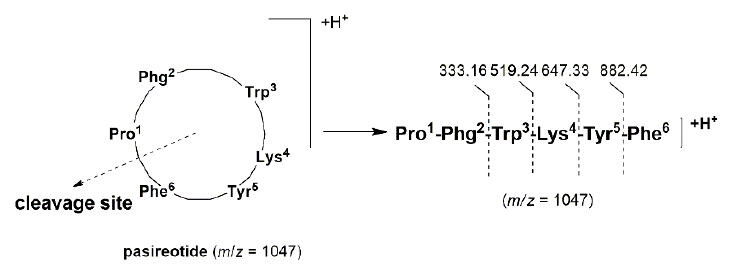
Scheme 6. Cleavage site of protonated pasireotide by MS / MS